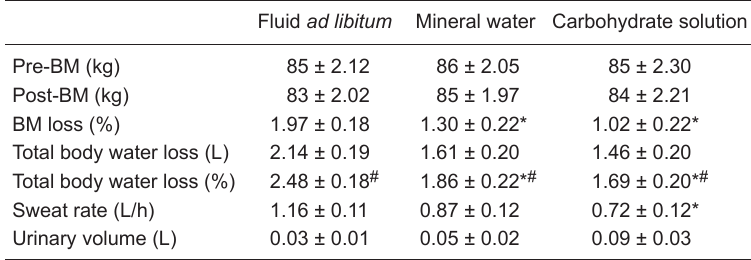
Table 1. Hydration status parameters under the three fluid replacement